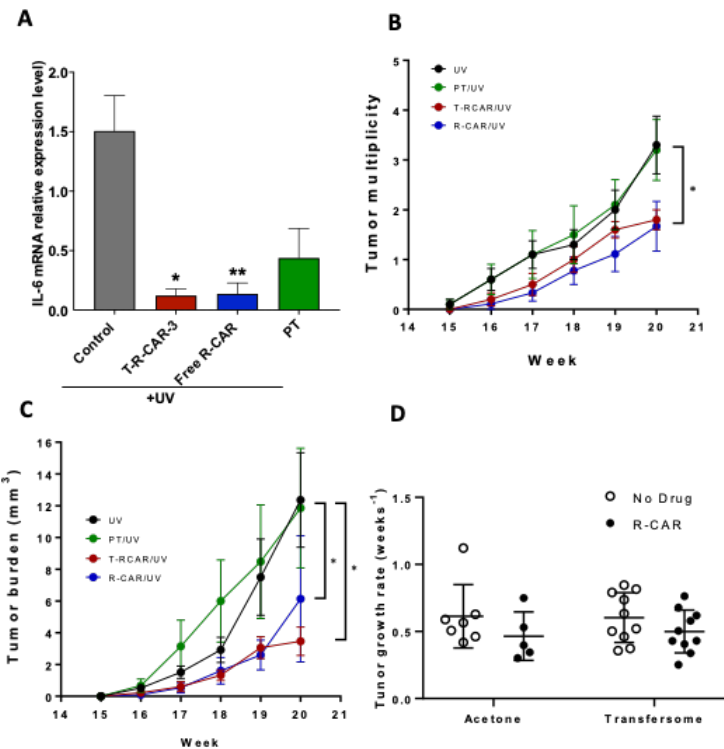
Figure 7. Effects of T-RCAR-3 and free R-carvedilol on UV-induced skin inflammation and tumor formation in SKH-1 mice. ( A ) Mice were pre-treated with vehicle (PEG 400), T-RCAR-3 gel, free